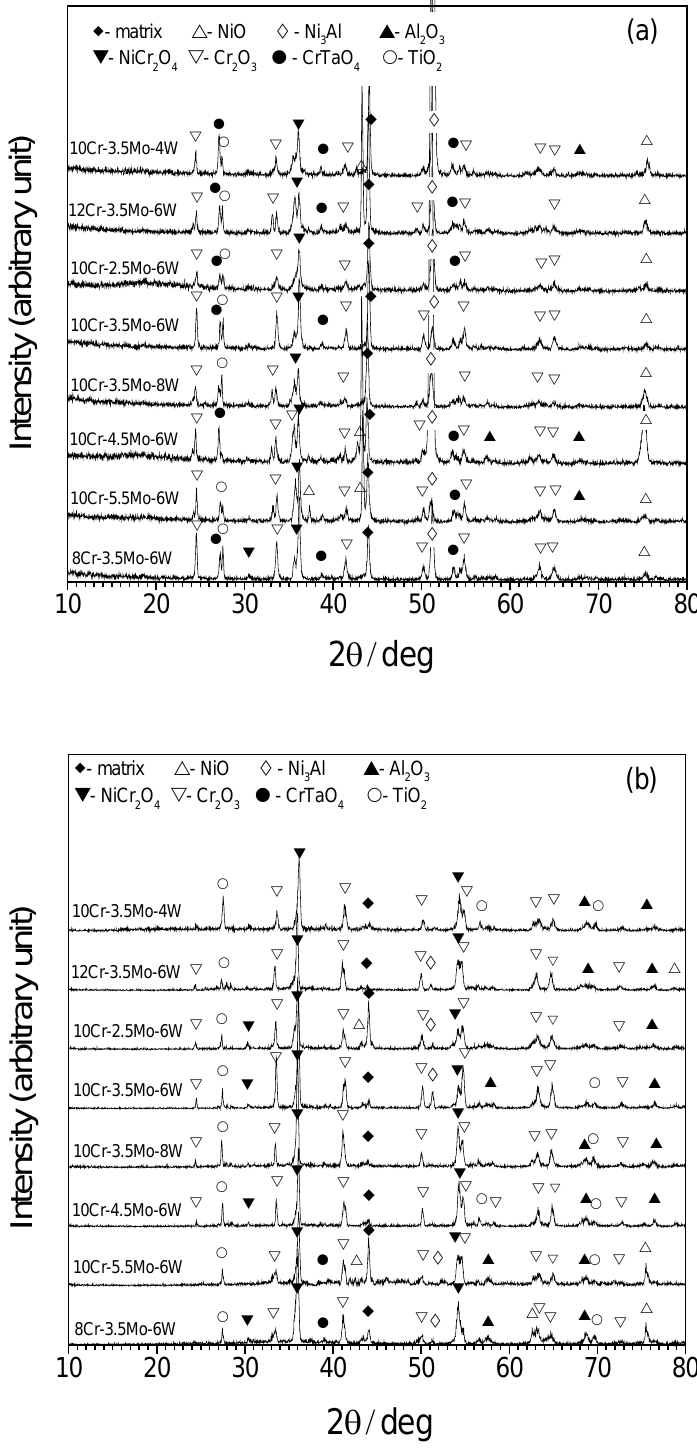
Figure 4. XRD pattern for the superalloys after oxidation tests ( a ) at 850 °C and ( b ) 1000 °C. The thickness of the oxide scale for the samples oxidized at 850 °C was several micrometers, as shown in Figure 5. The scale layer was mainly composed of Cr 2 O 3 and discontinuous particles of Al 2 O 3 were present just beneath the Cr 2 O 3 layer. TiO 2 was often found at the outermost part of the scale.